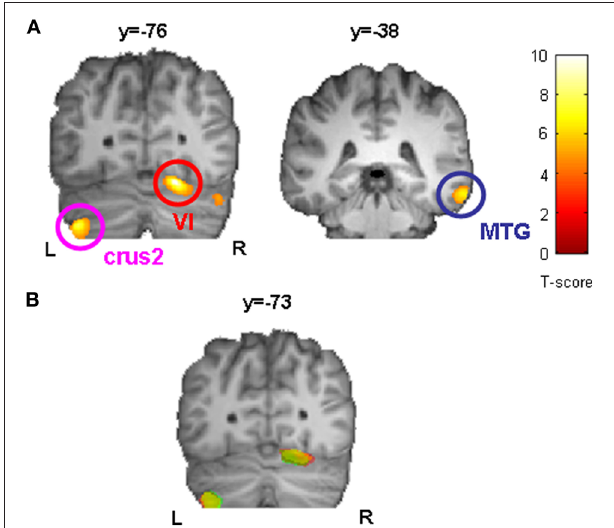
FIGURE 4 | Correlation analysis between initial GM volume on day 1 (before motor skill learning) and sequence-specific performance improvements in SPFT [%] indicated that bilateral cerebellum (right: cerebellar lobule VI, left: cerebellar crus2) and right middle temporal gyrus (MTG) served as a predictor for successful sequence-specific motor skill learning (A). Furthermore, initial GM volume in bilateral cerebellum (right: cerebellar lobule VI, left: cerebellar crus2) also predicted the amount of structural changes (GM volume changes [%], see also Figure 3 ) after sequence-specific motor learning in left M1 (yellow), right PMC (green), and DLPFC (red). Statistically significant clusters are summarized in (B) and projected onto a DARTEL template. All images are shown at p < 0 . 001 on voxel-level and FWE-corrected on cluster level ( p < 0 . 05). L, left; R,